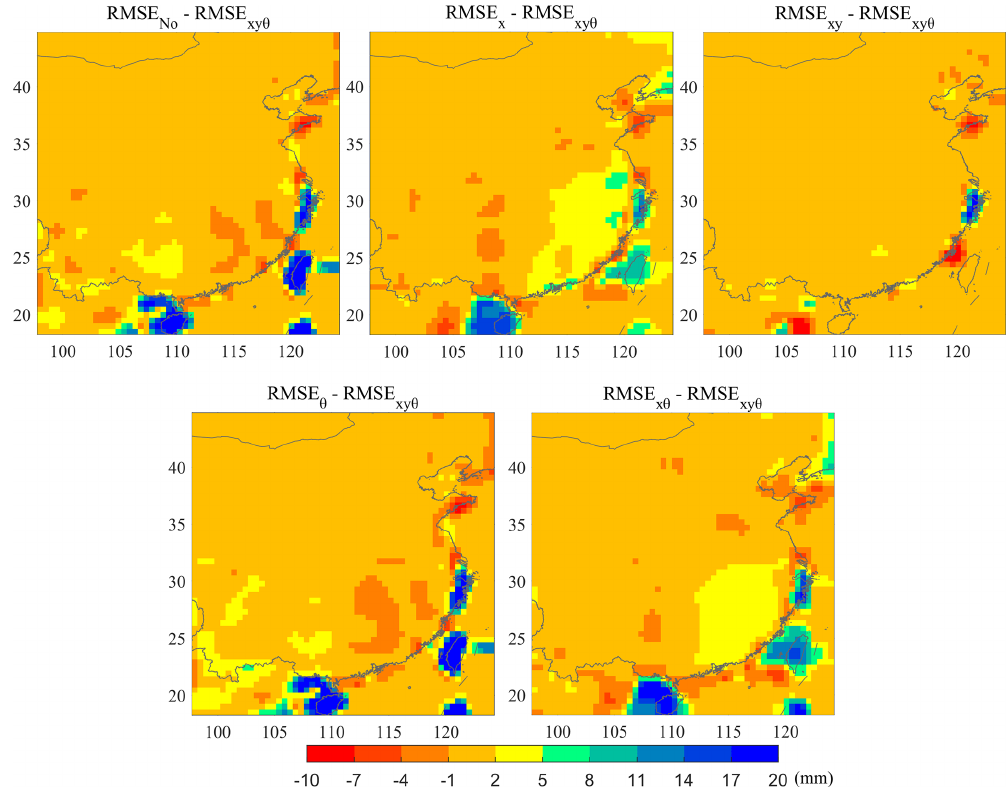
Figure 7. The difference of the predictive RMSE between the proposed method and other uncertainty processing approaches for precipitation